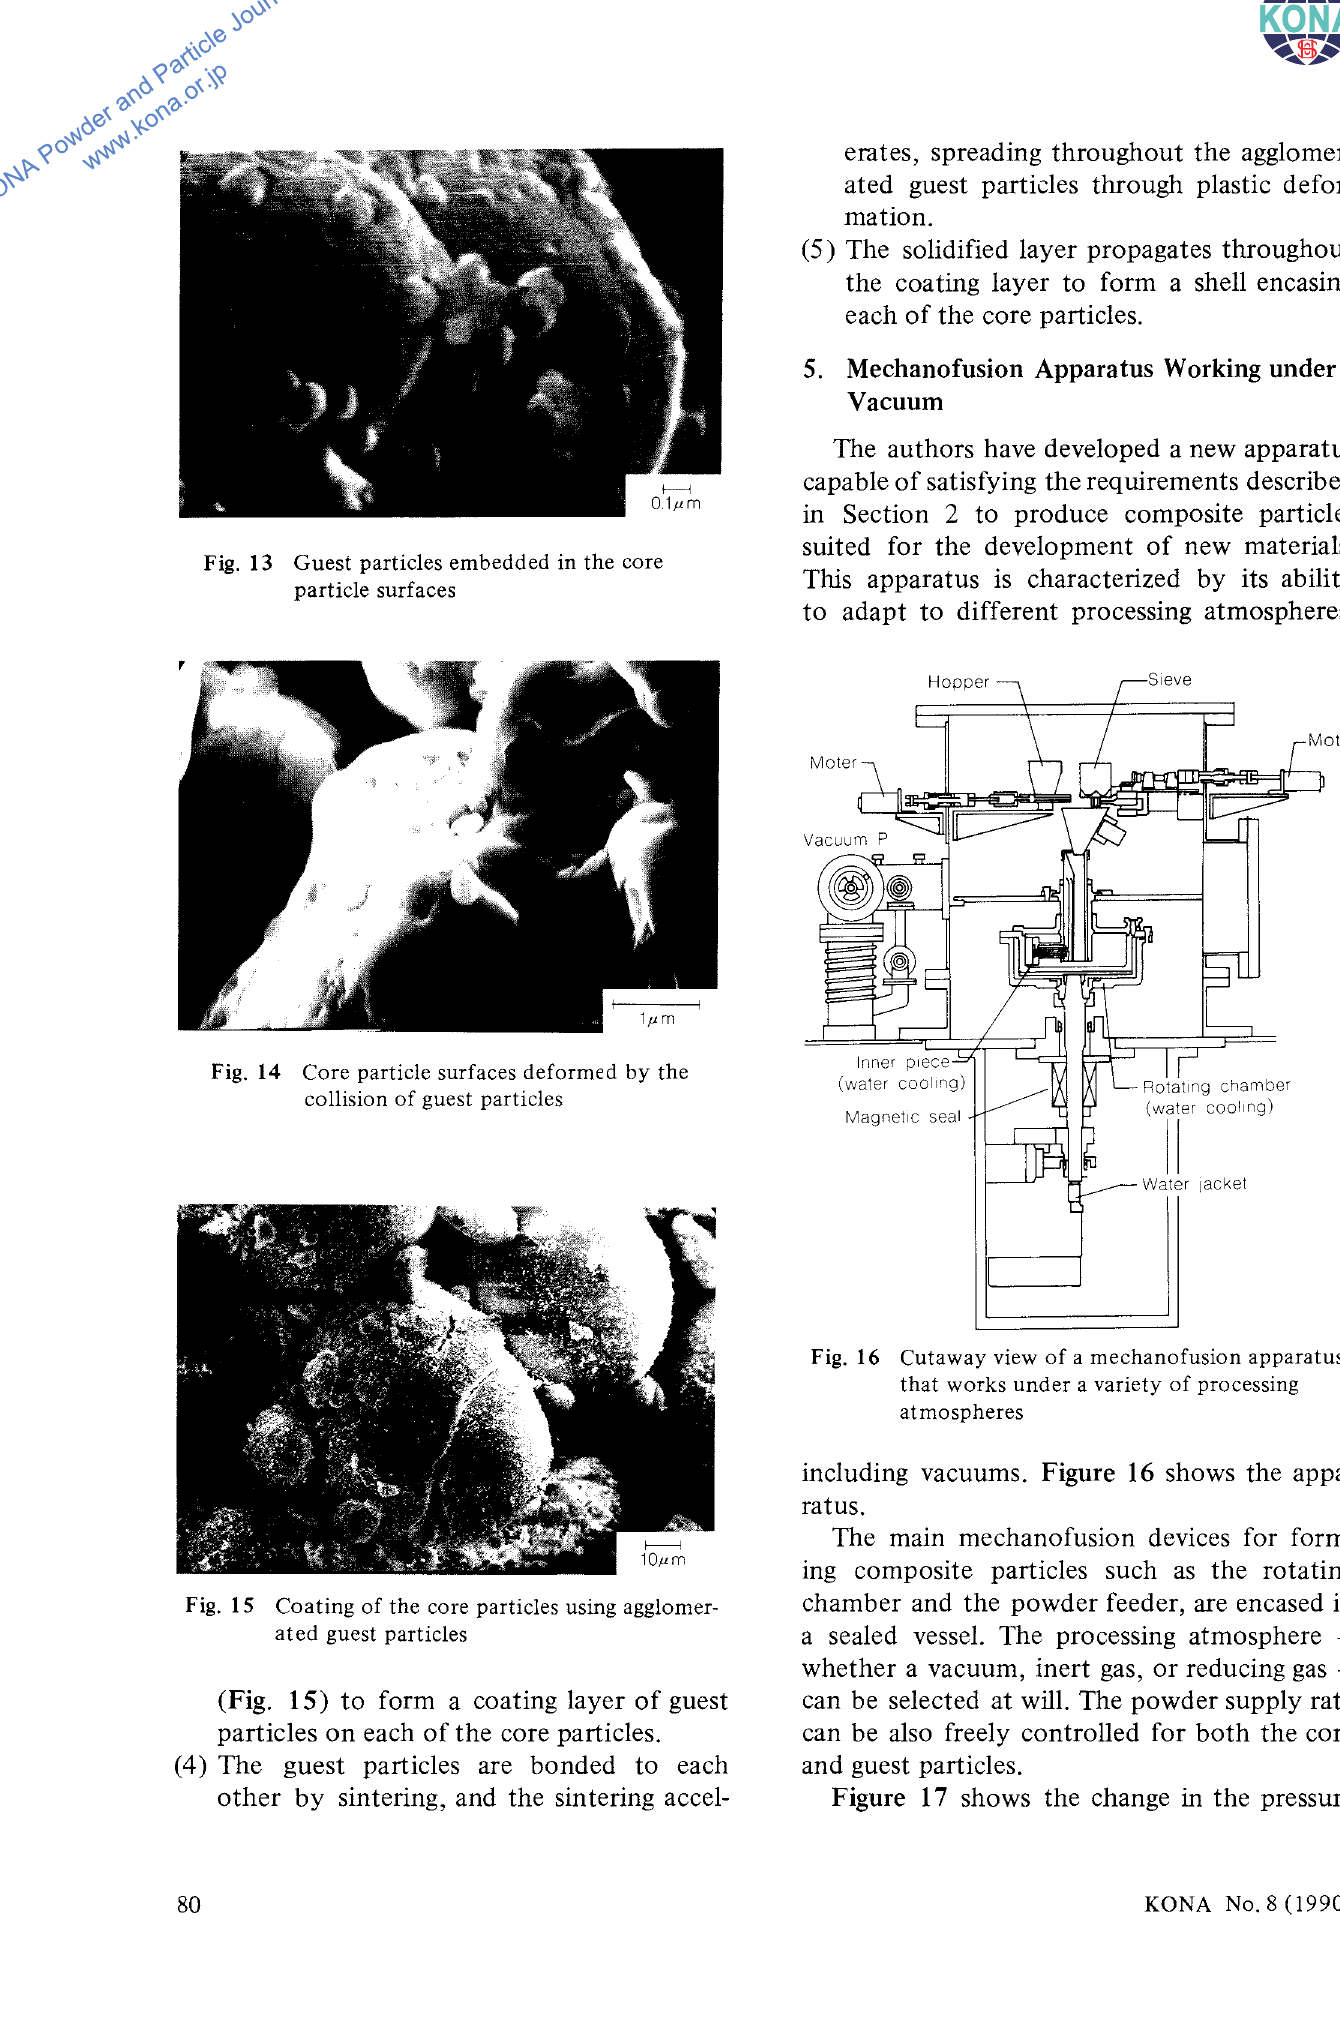
Fig. 15 Coating of the core particles using agglomer ated guest particles